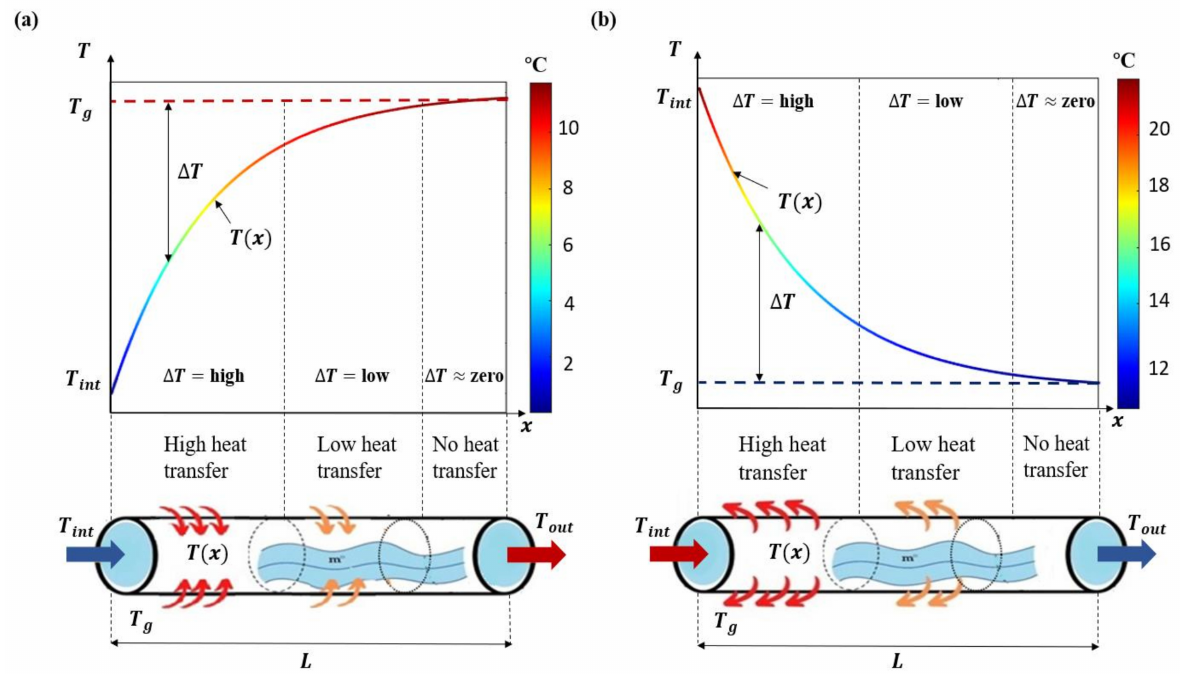
Figure 2. Schematic diagram of heat transfer profile for the GHE’s behaviors in ( a ) heating mode and ( b ) cooling mode. T (temperature), T int (input temperature), T out (output temperature), T(x) (water temperature at position x ), T g (ground temperature), ∆ T (temperature difference), and L (pipe